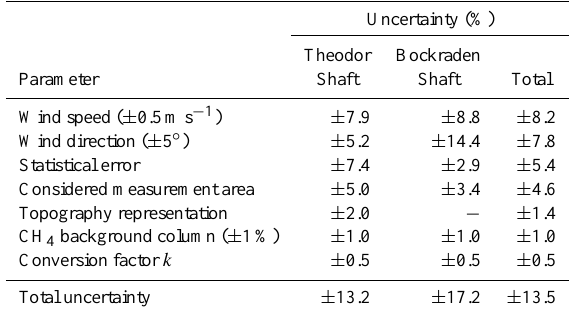
Table 5. Uncertainties by parameter on the inversion results for the individual ventilation shafts and for the total coal